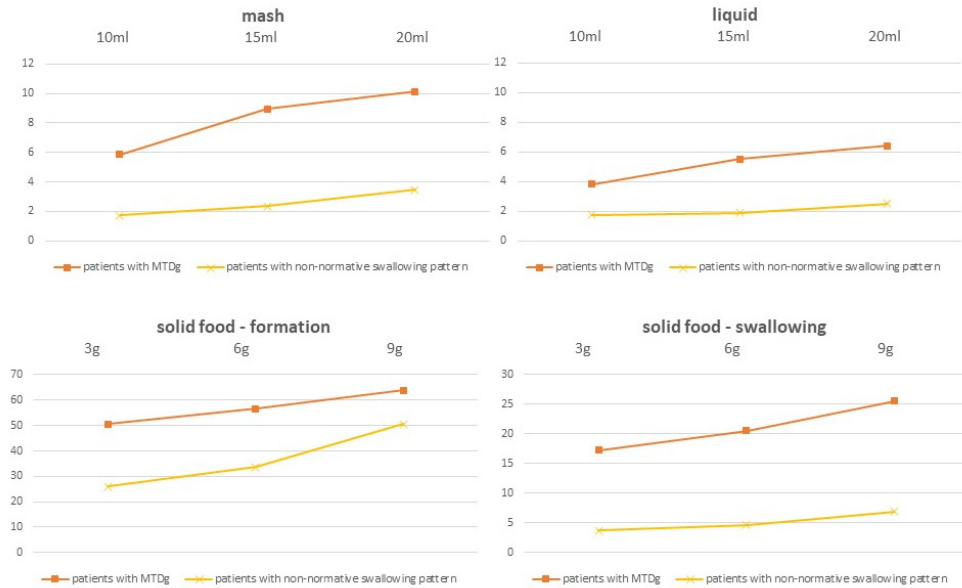
Figure 1. Duration of food swallowing and chewing in the subgroups of patients.